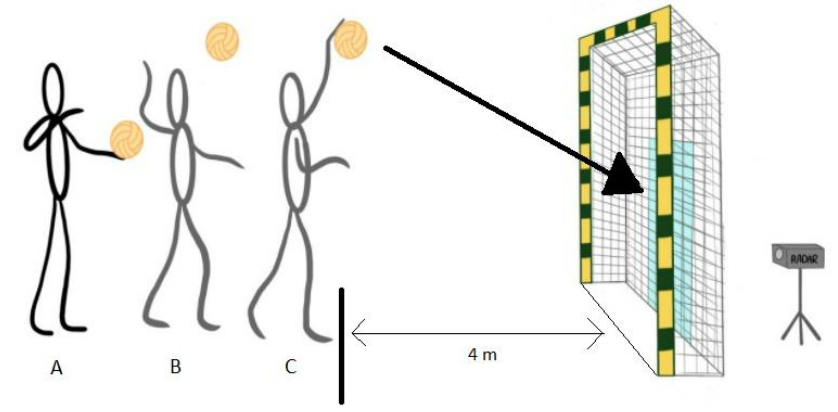
Figure 2. The maximal standing spike test.